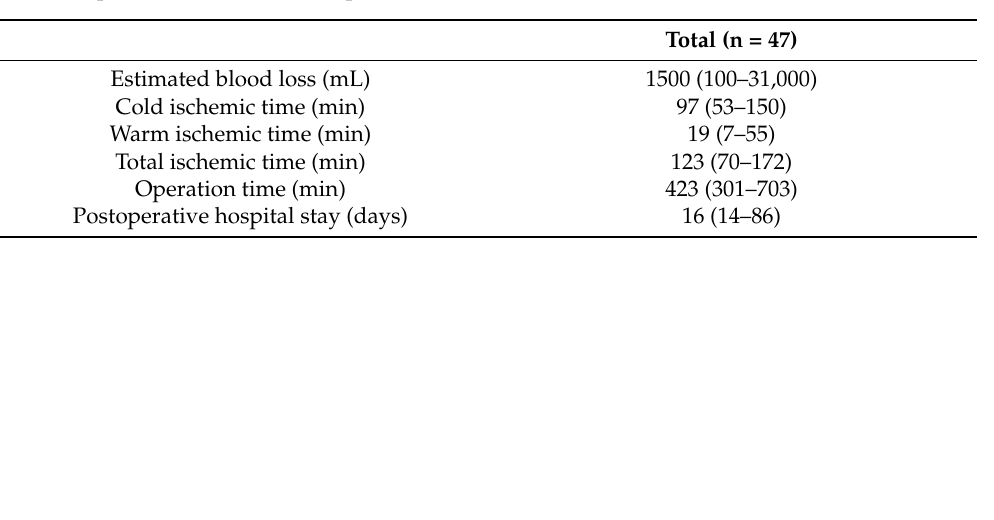
Table 3. Operative outcomes of recipients that underwent